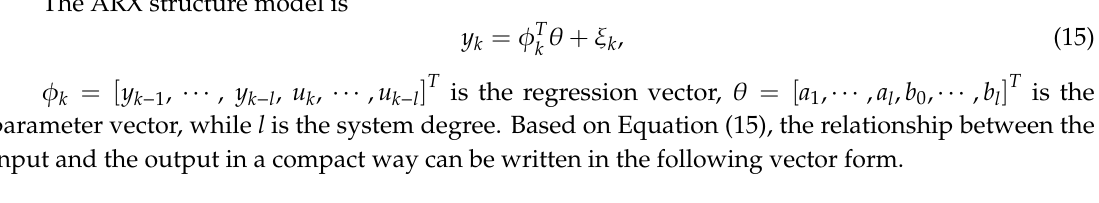
Figure 2. Scheme for linear system modeling based on auto-regressive and exogenous (ARX) structure. The ARX structure model